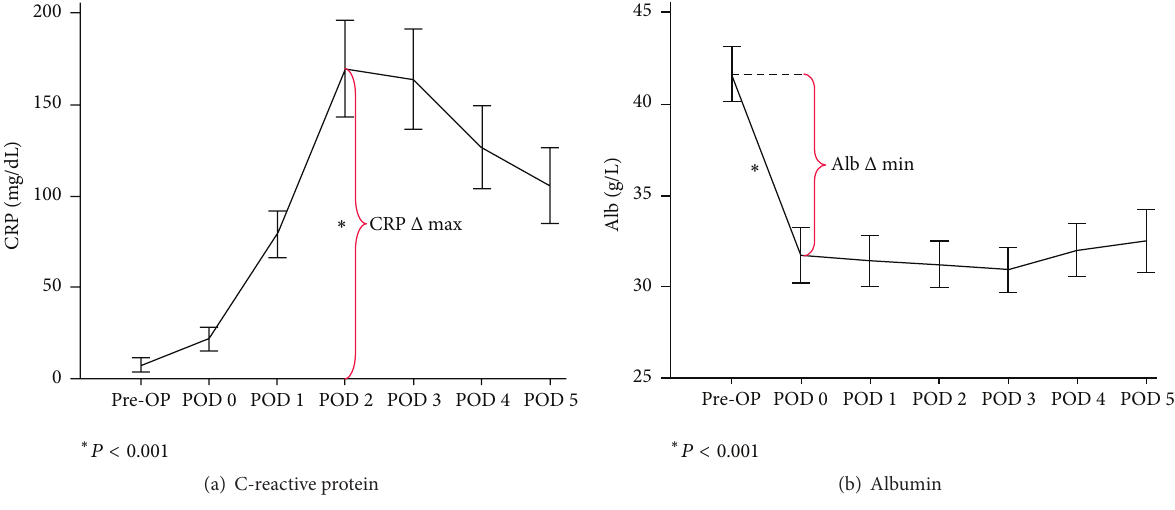
Figure 1: Acute inflammatory response after abdominal surgery as reflected by albumin and CRP kinetics. C-reactive protein (CRP) and albumin were measured preoperatively (pre-OP), 6 hours after surgery, and on postoperative days (POD) 1–5. CRP levels peaked (CRP Δ max) on POD 2 (a), while minimal albumin levels (Alb Δ min) were measured already 6 hours after surgery (b).